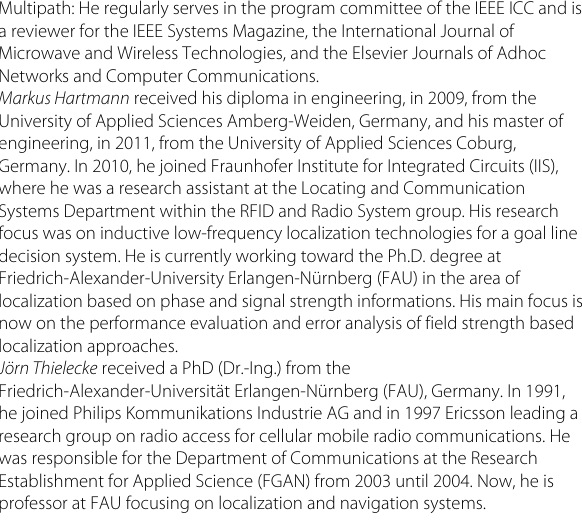
Endnote 1 Dynamic Adaptable Applications for Bats